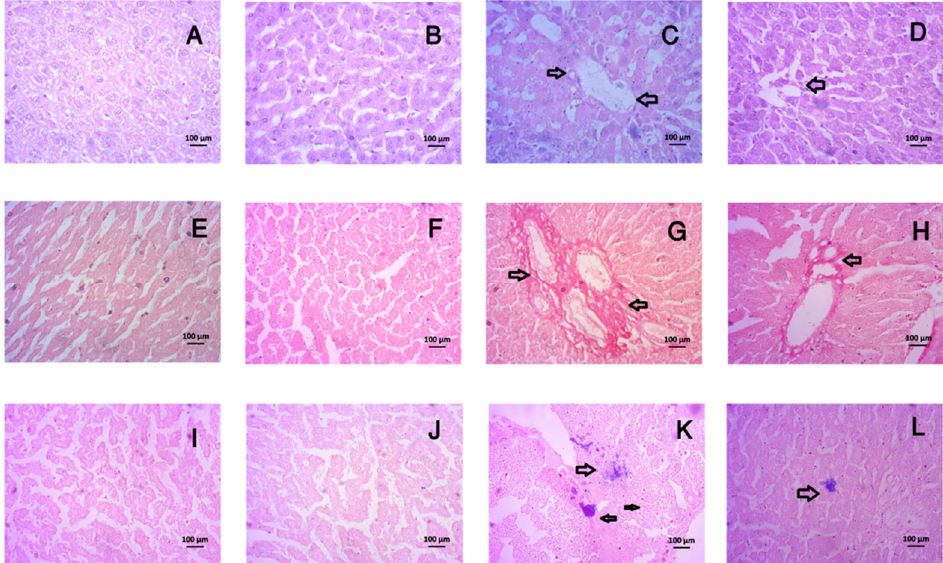
Figure 8. Effect of tempol on liver histology in CCl 4 -administered rats. In this figure ( A – D ) is hematoxylin and eosin staining; ( E – H ) is Sirius red staining and ( I – L ) is Prussian blue staining. Here, ( A , E , I )—Control; ( B , F , J )—Control + tempol; ( C , G , K )—CCl 4 and ( D , H , L )—CCl 4 + tempol. All pictures were taken at 40× magnification.